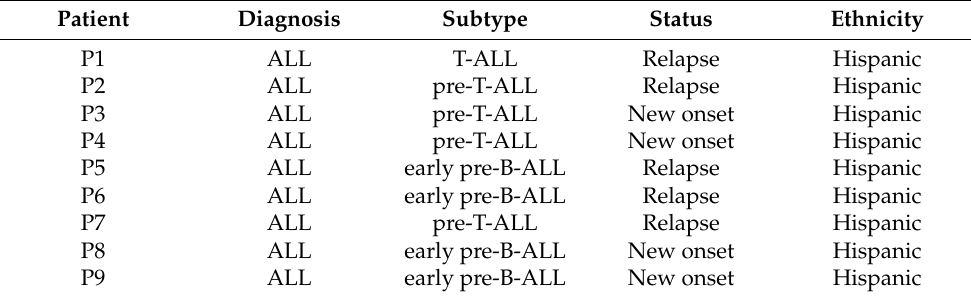
Table 1. Patient information.